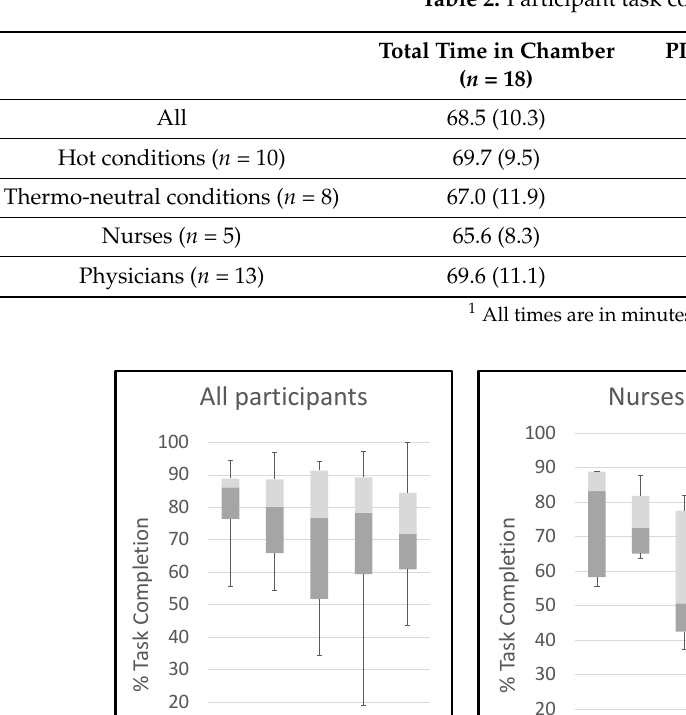
Table 2. Participant task completion times 1 .